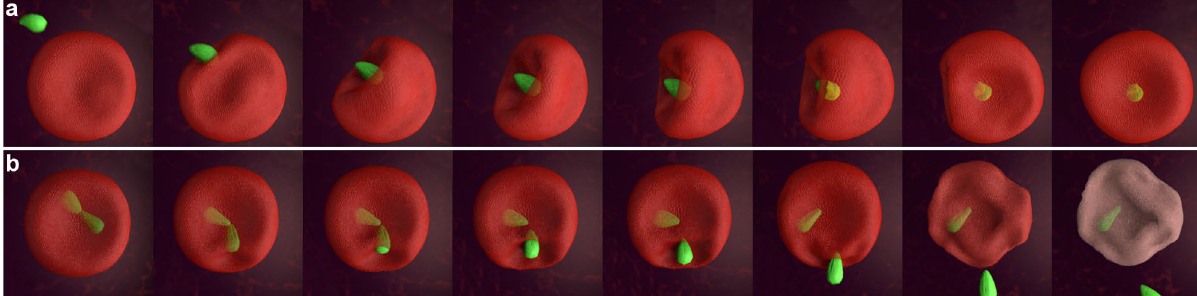
Figure 6. Serial diagram showing the most representative steps of the invasion and egress process of B. divergens . ( a ) The merozoite contact with the erythrocyte is vigorous and cause a deep invagination and waves of deformation on the erythrocyte membrane plasma during the entry. ( b ) Serial events represent a novel mechanism of egress used by B. divergens to exit the human erythrocyte. The intraerythrocytic parasite attaches to the erythrocyte to internalize the erythrocyte plasma membrane, a strategy that could be used by the parasites to exit the